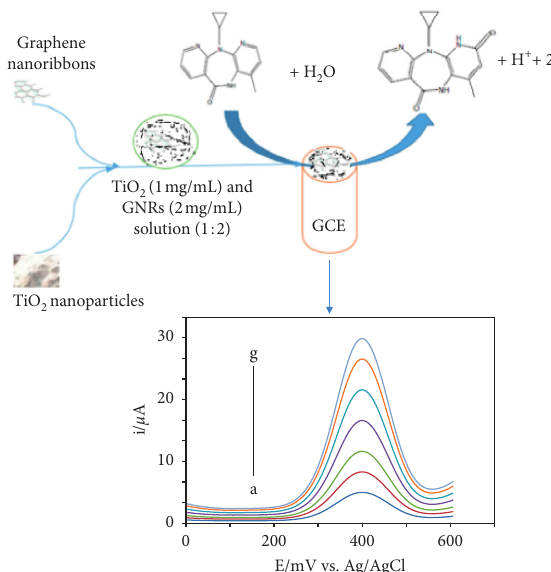
Scheme 1: The fabrication procedure of the electrochemical